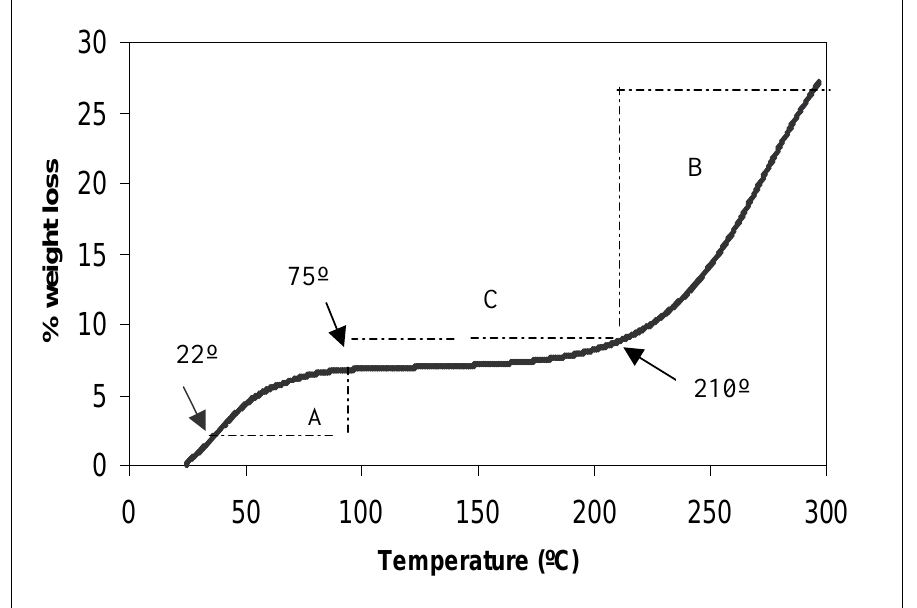
Figure 5. Percent of weight loss of 65 KDa Pani in varying